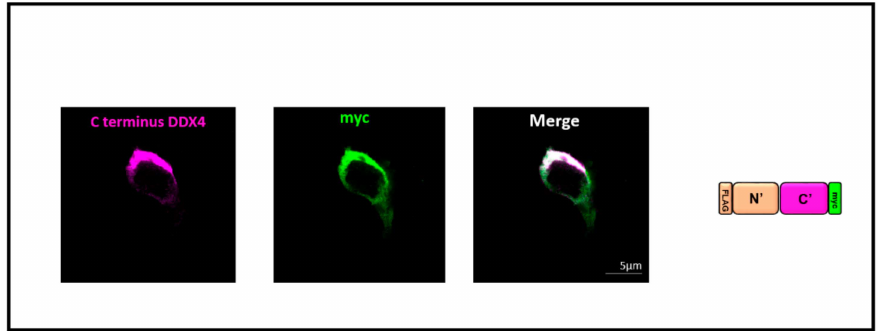
Figure 4. RFP does not a ff ect the cellular localisation of DDX4. RFP was removed from the pFLAG-DDX4-myc construct and when transfected human embryonic kidney (HEK) 293T cells were immunostained with an antibody against the C-terminus of DDX4 (magenta) and the myc tag (green), surface fluorescence was observed. This confirmed that RFP did not a ff ect the cellular localisation of DDX4. The colour schemes on the protein schematic mirror the fluorophores used for staining those particular regions of the corresponding protein. Scale bar, 5 µ